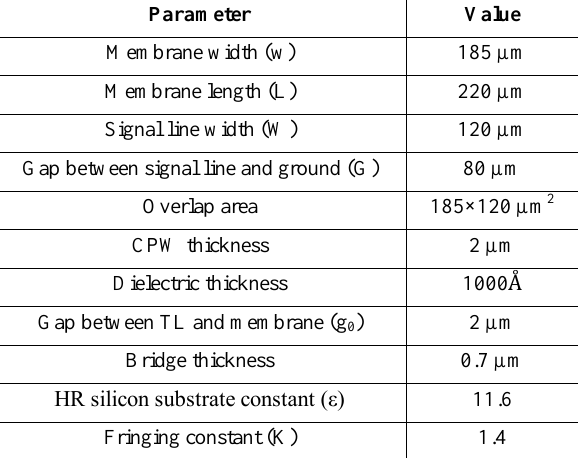
Table 1. RF MEMS switch